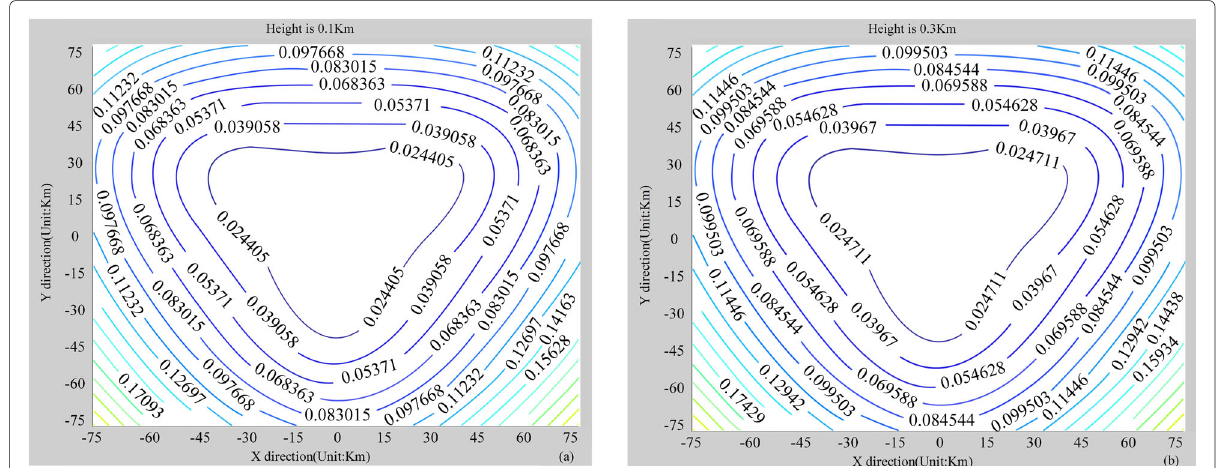
Fig. 5 Influence of the height of the base station on positioning accuracy